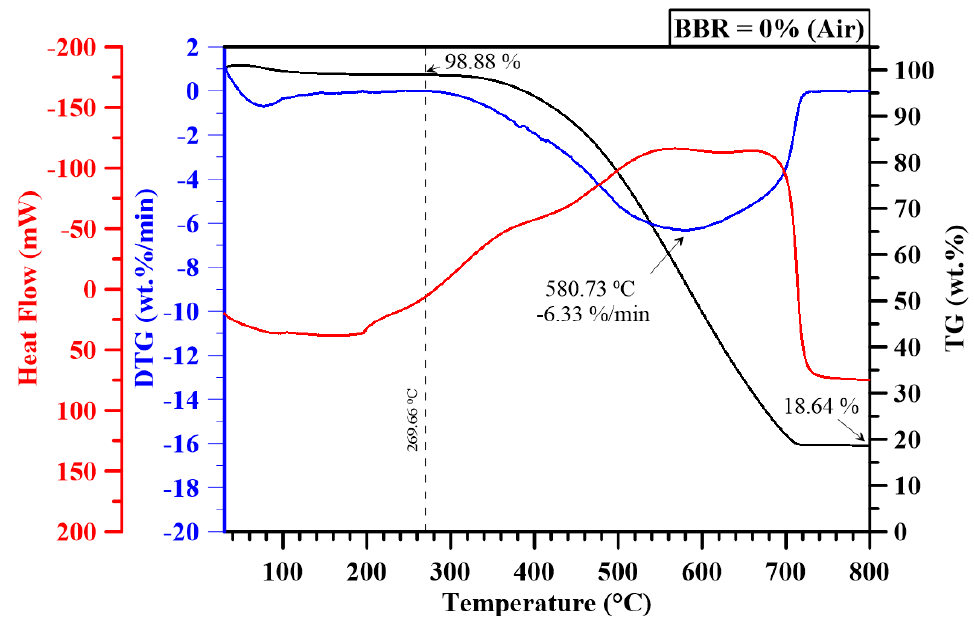
Figure 4. Thermogravimetric analysis results of Australian black coal under combustion condition.